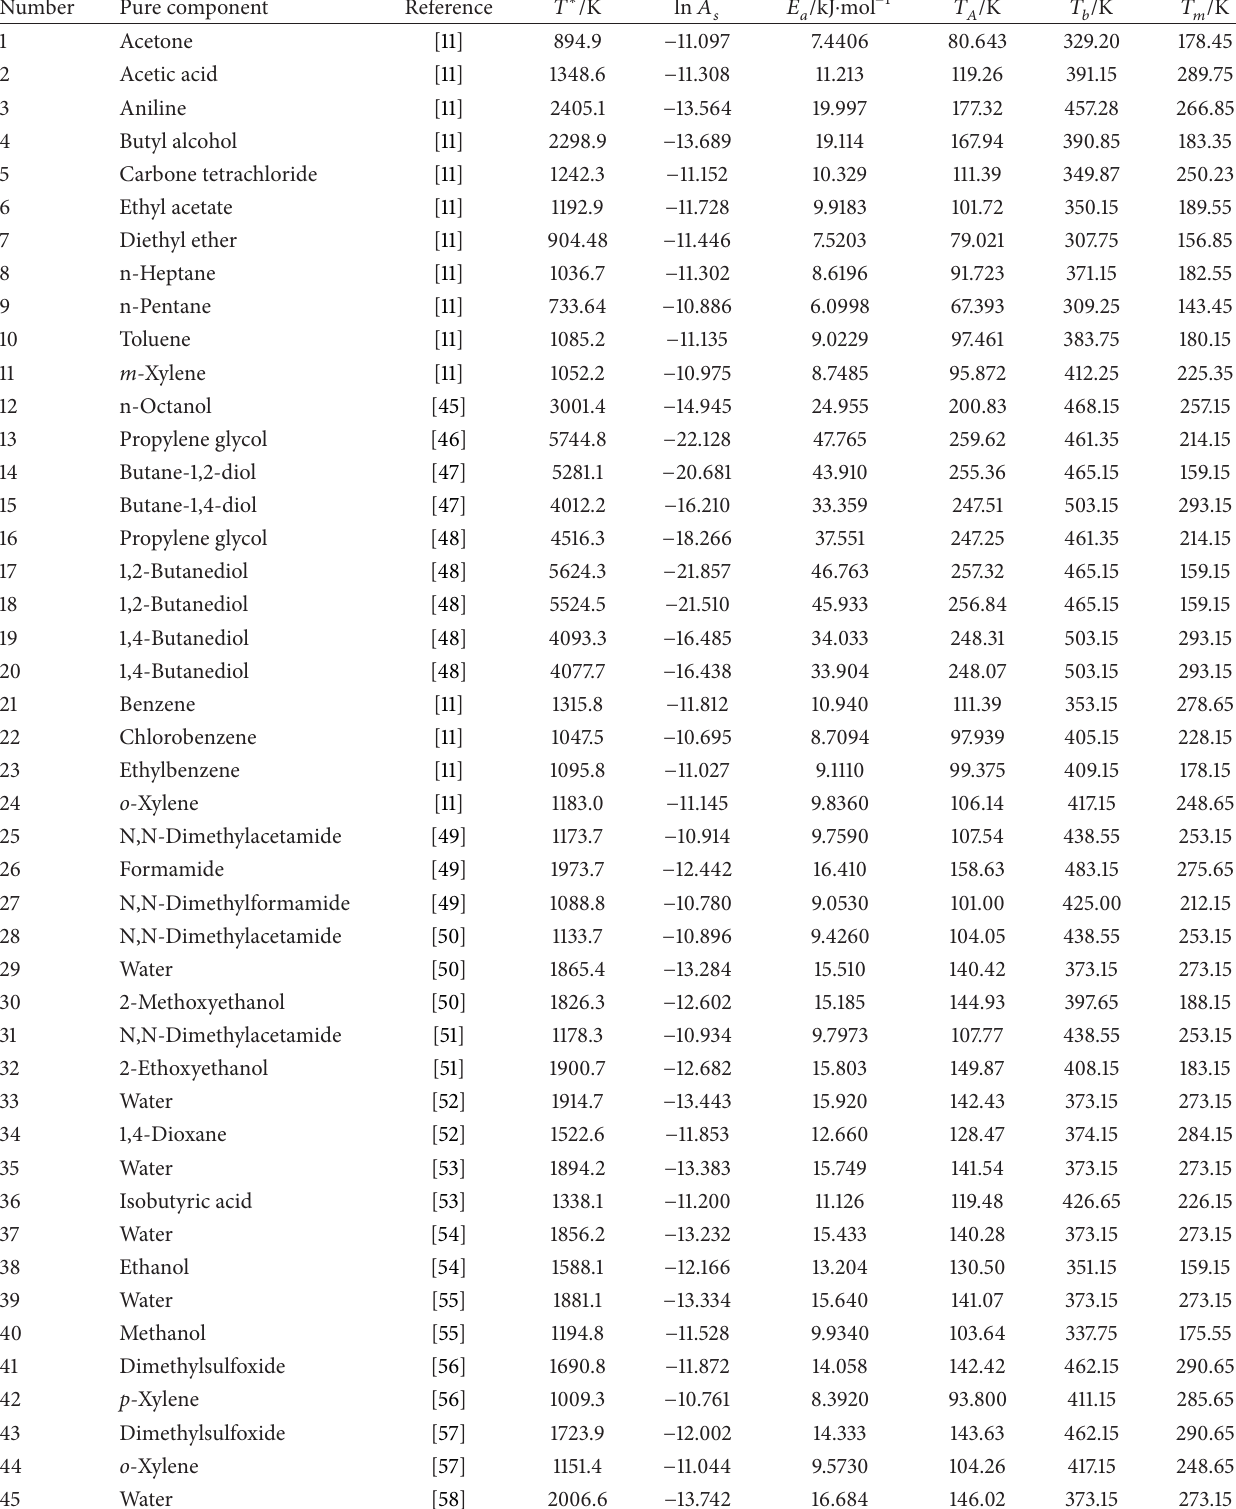
Table 1: Arrhenius parameters of some pure liquids studied at previous works, Arrhenius activation energy 𝐸 𝑎 (kJ ⋅ mol −1 ), the logarithm of the entropic factor of Arrhenius ln (𝐴 𝑠 /Pa ⋅ s), the Arrhenius temperature ( 𝑇 𝐴 /K), Arrhenius activation temperature ( 𝑇 ∗ /K), the melting point ( 𝑇 𝑚 /K), and the boiling point ( 𝑇 𝑏